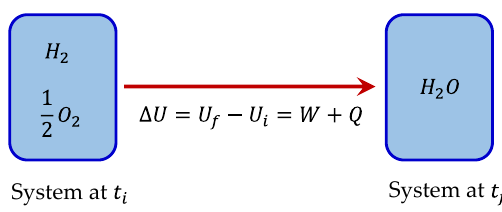
Figure 3. Fuel cell systems (FCS) functional principle. In the case of transport, and for reasonable cruising speeds, the power required is determined by the mass of the vehicle which governs the acceleration phases as well as the sloping road cases. Autonomy, on the other hand, is only correlated to the size of the fuel tank and its recharging speed. For battery vehicles, the reactants must be stored within the accumulator electrodes in order to ensure the desired autonomy: to guarantee occasional needs for long autonomy, the user must then accept a significant extra cost and overweight by purchasing a high-capacity battery vehicle. Conversely, the main cost of the FCV is related to its converter (power) while the increase in storage (energy) has a much lower impact on mass and cost. Moreover, its recharging by material transfer is very fast which implies that a range of 500 km to 600 km is more than adequate. The Japanese manufacturer Toyota, which is devoting major efforts to the development of hydrogen mobility, illustrates this in Figure 4 through the overall cost of the two types of electric vehicles as a function of the required range. Figure 4. Comparison of battery vehicles (EV) and fuel cell vehicles (FCVs) [13]. Applying the first thermodynamics law to the system in Figure 5 shows that the global reaction